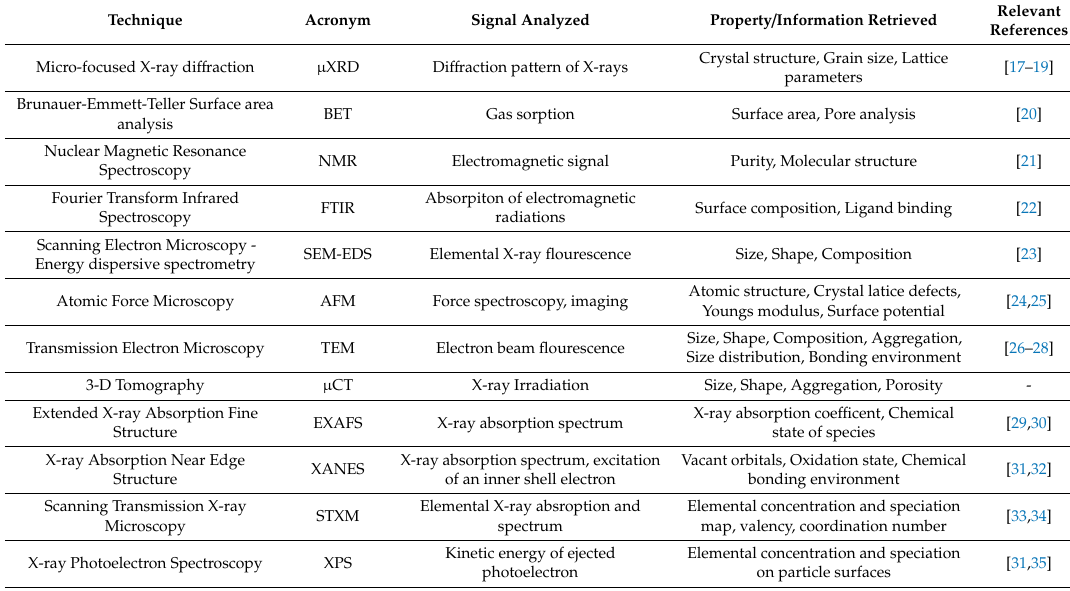
Table 1. Overview of techniques used to study Fe nanoparticles and